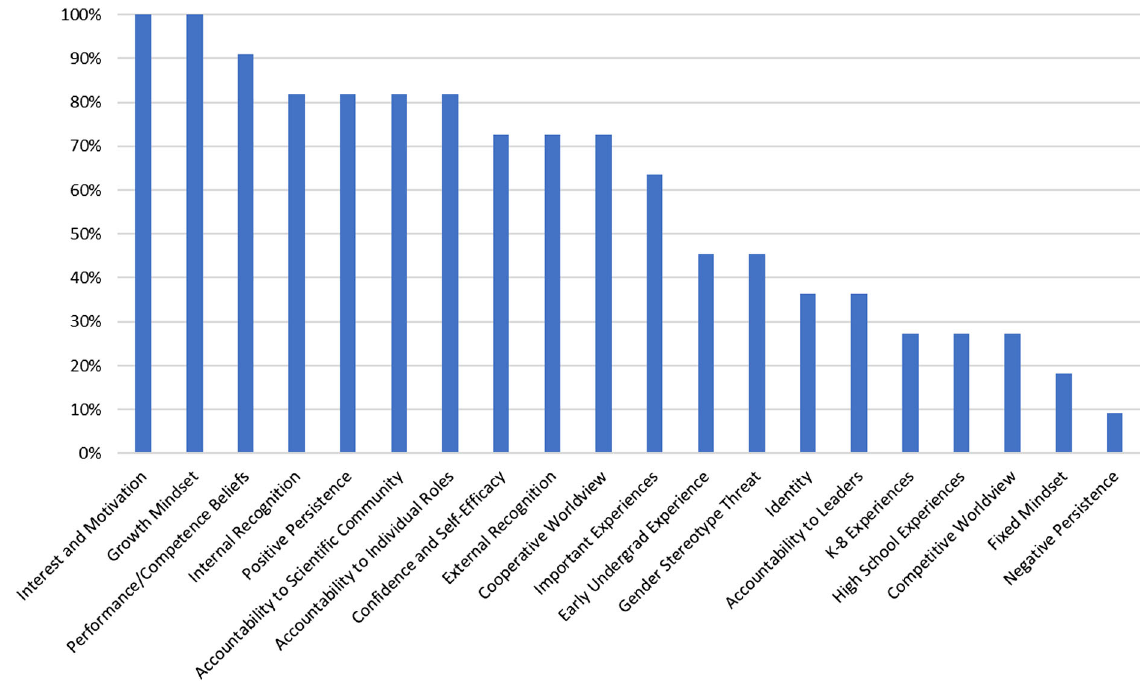
FIG. 1. Frequency with which themes appeared in each